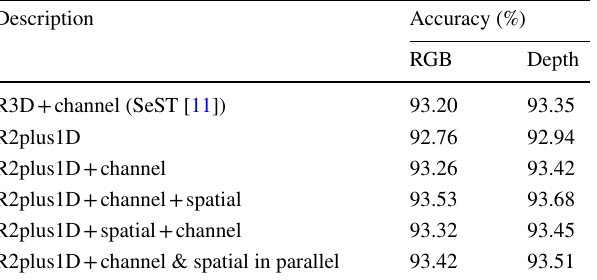
Table 2 Comparison methods of the CAM and SAM on EgoGesture